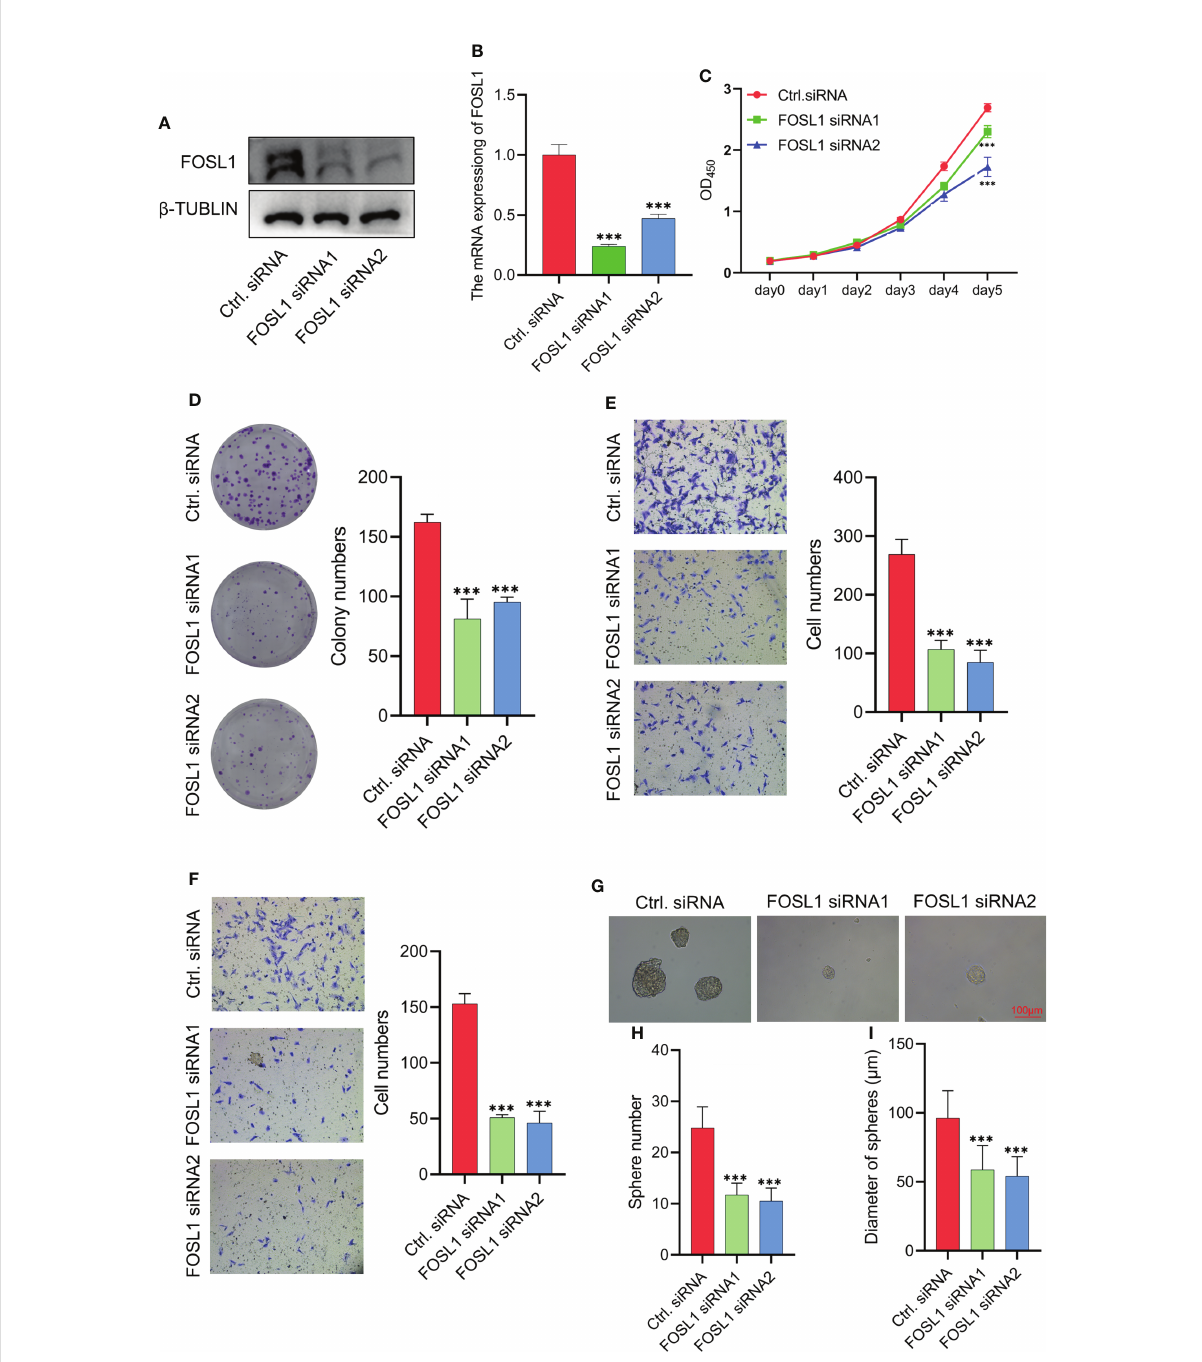
FIGURE 2 Knockdown of FOSL1 inhibits cell proliferation, migration, invasion, and tumor sphere formation in Ams (A, B) Western blotting and RT-qPCR analyses con fi rmed the knockdown of FOSL1 in AM cells. ***p < 0.001 by one-way ANOVA. (C – F) CCK-8 assay (C) , colony formation assay (D) , migration assay (E) , and invasion assay (F) were performed on AM cells transfected with control or FOSL1 siRNAs. ***p < 0.001 by two-way ANOVA. (G – I) Tumor sphere formation was performed on AMs transfected with the control or FOSL1 siRNAs. ***p < 0.001 by one-way